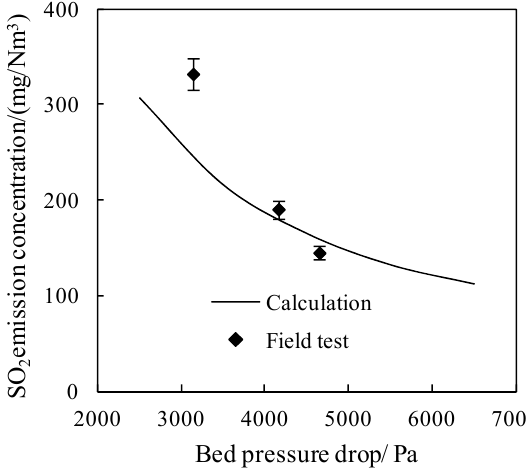
Figure 5. Effect of bed pressure drop on bed temperature (Reprint with permission [6]; 2015, Powder Technol.).